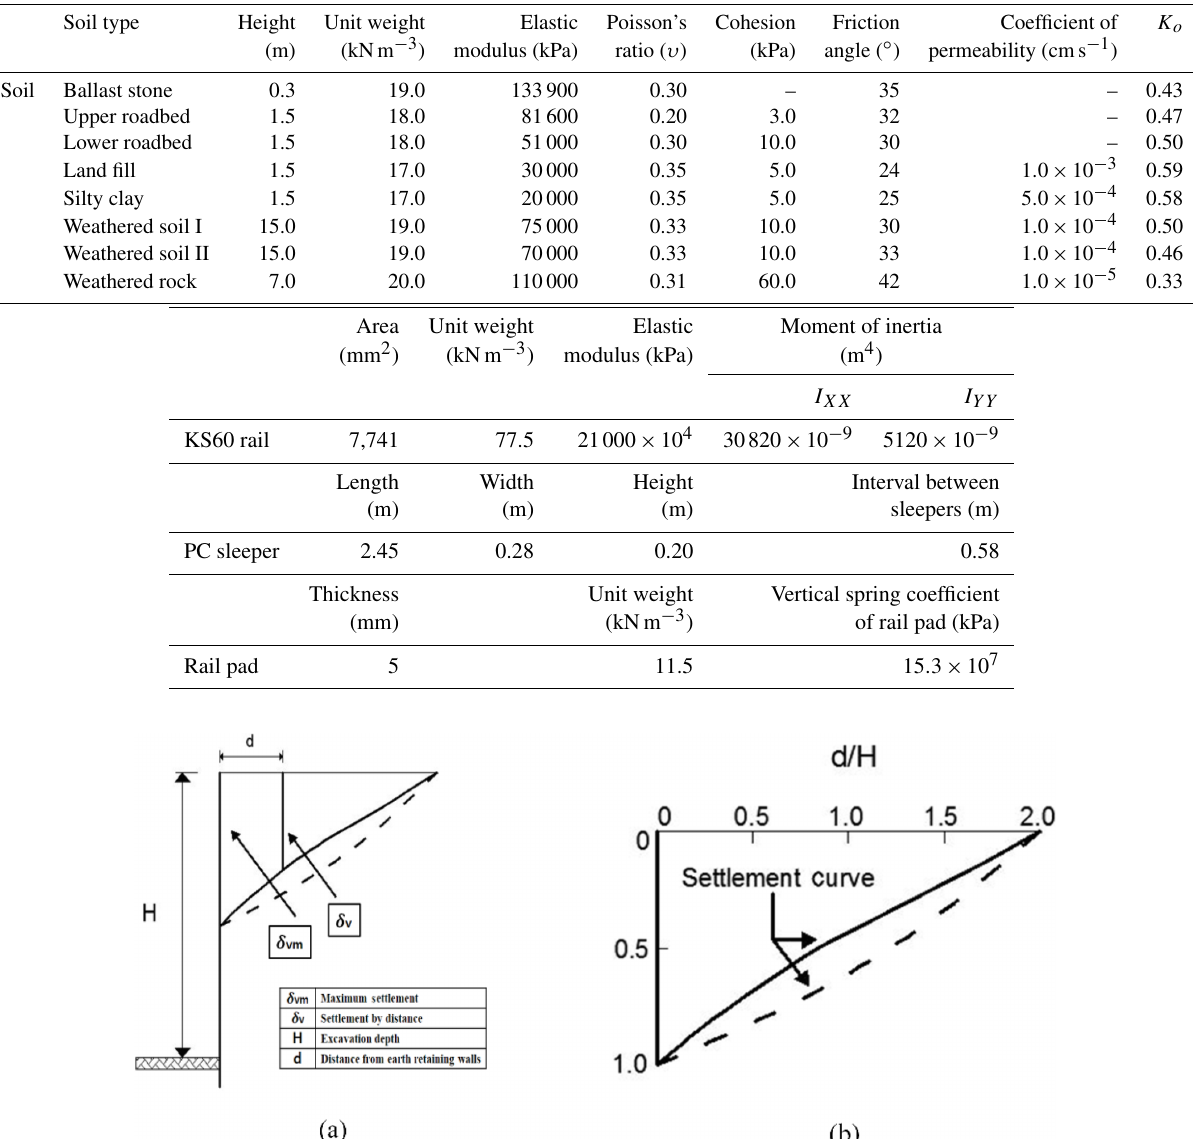
Figure 4. Settlement of clay and sand backfill with respect to the distance from earth retaining walls: (a) settlement of backfill and (b) pre- diction of